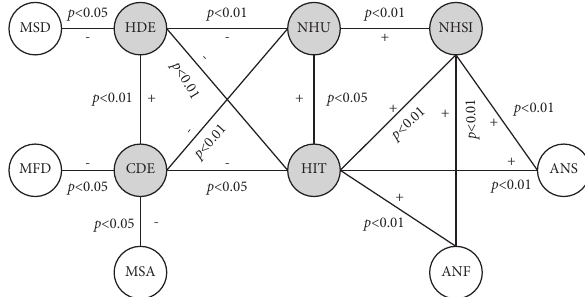
Figure 3: Correlation between indices of hazard perception and eye movement.